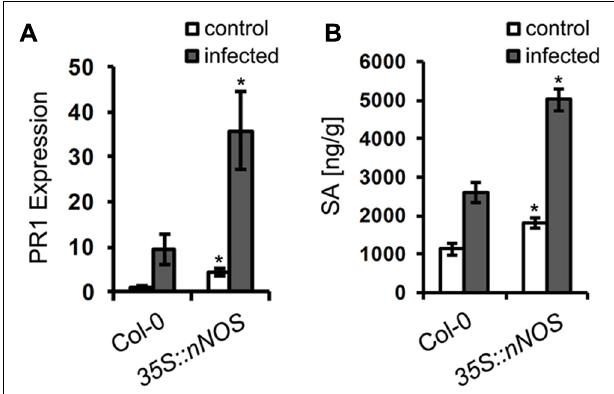
FIGURE 8 | Salicylic acid content and PR1 gene expression are upregulated in 35S::nNOS plants. 6-week-old Arabidopsis plants, wild type and 35S::nNOS , were inoculated with Golovinomyces orontii and leaves harvested for analysis at 24 h post-inoculation. (A) Relative expression of the PR1 gene was determined by qRT-PCR (normalized to actin gene expression) and the value of unchallenged Col-0 plants set to 1. (B) Quantification of total SA levels. All values are the mean ( ± SD) of six plants taken from two separate experiments. In both graphs ( A and B ), asterisks indicate a significant difference ( p < 0.01) of mutant relative to wild type